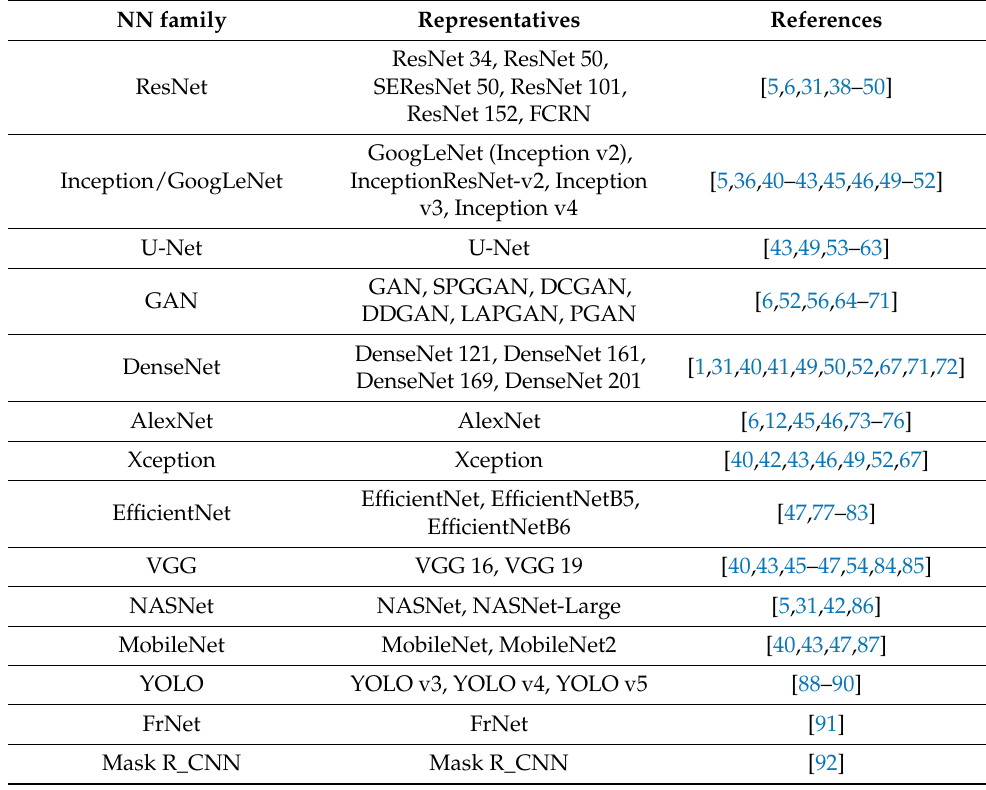
Table 3. Family of NNs used for Me diagnosis used in references.